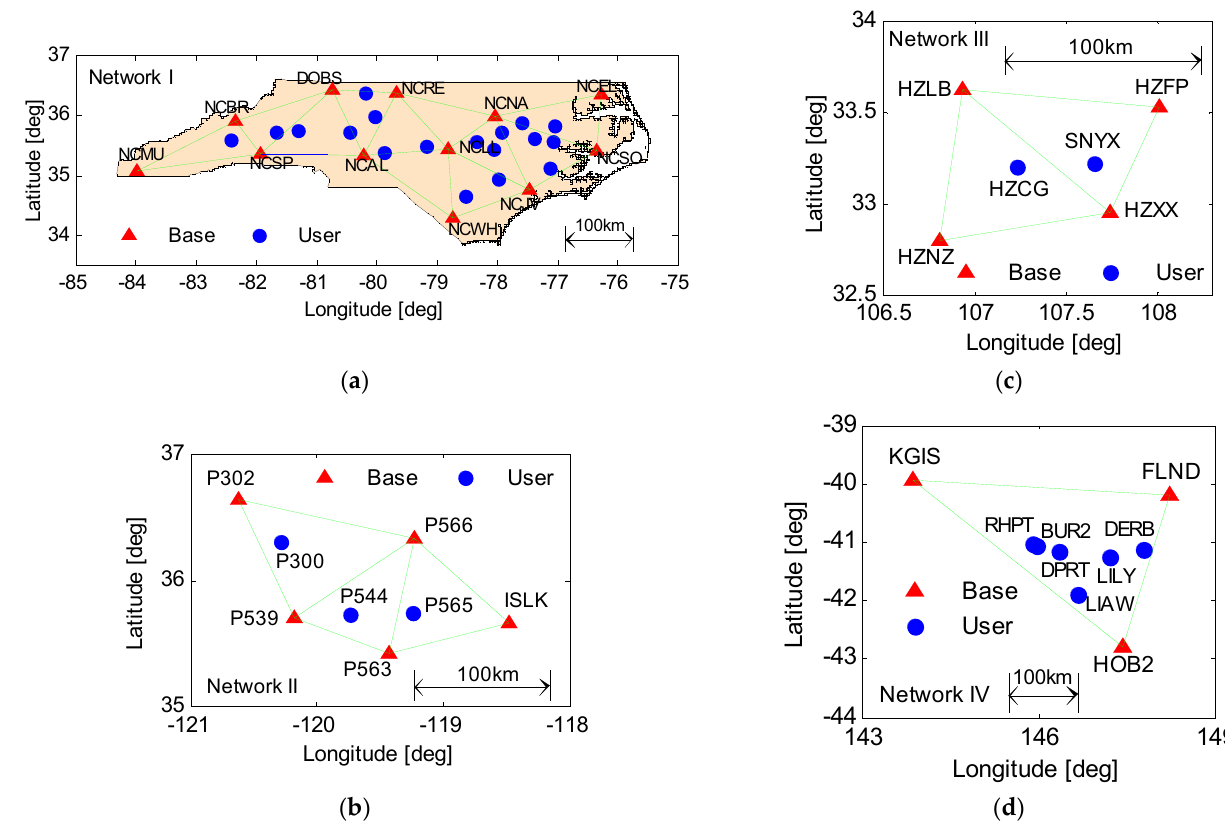
Figure 2. Global MGEX stations distribution for multi-frequency FCB estimation.